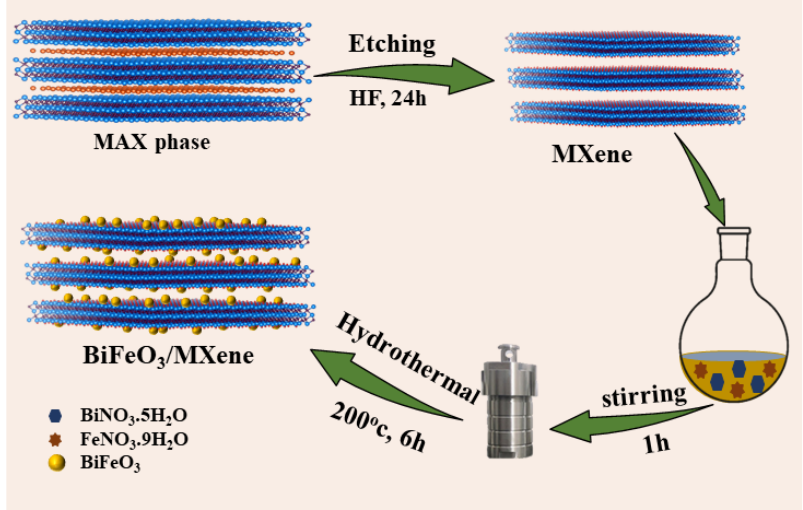
Scheme 1. Preparation of BiFeO 3 nanoparticles on layered MXene.